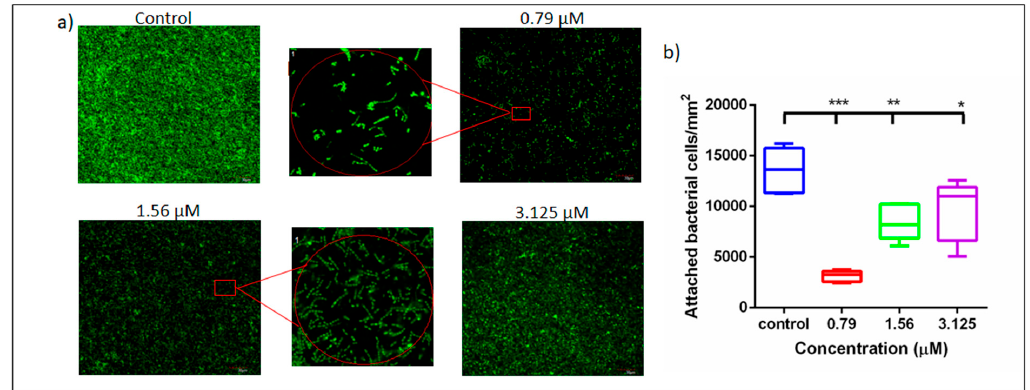
Figure 3. Confocal laser scanning images showing inhibition of multispecies biofilms by DMTU. ( a ) Panel shows the reduced green fluorescence (indicating less biofilm formation) when treated with different concentrations of DMTU; inset picture shows predominance of S. gordonii in treated biofilms; ( b ) total number of attached cells in each biofilm scaffold showing significant inhibition of biofilm formation at the tested concentrations. * denotes p ≤ 0.05, ** denotes p ≤ 0.01 and *** denotes p ≤ 0.001.